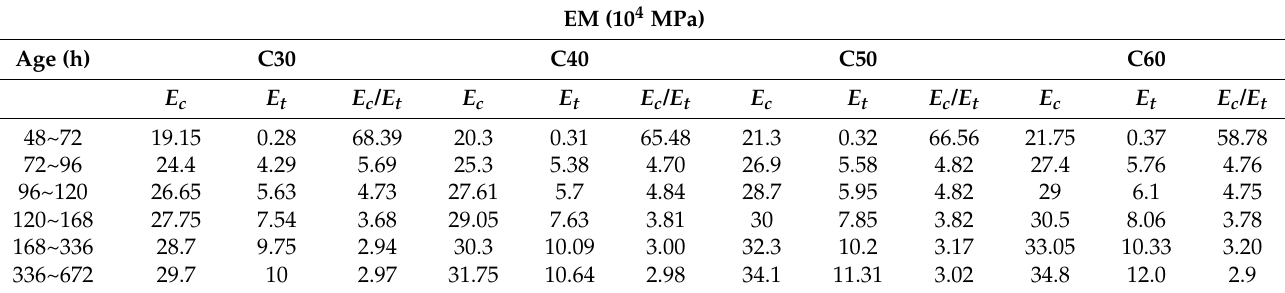
Figure 8. The development trend of the elastic modulus of a micro-matrix around the capillary ( E t ). Table 8. Elastic modulus comparative